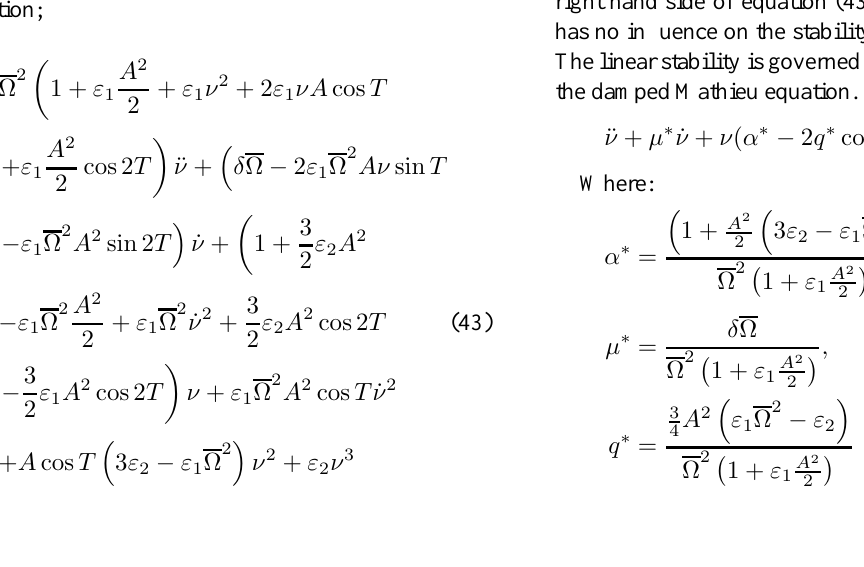
Fig. 4. Steady state frequency response and the instability boundary of the first mode, for the concentrated load case, i.e. ε 1 = 1 . 0449 , ε 2 = 0 . 9329 , ε 3 c = 0 . 17974 , δ = 0 . 02 and P = 0 . 2 , —— SHB-C, - - - - Instability Boundary. introducing a small perturbation ν ( T ) , i.e. by substi- tuting u ( T ) = A cos( T )+ ν ( T ) , into the equation (26), followed by use of the steady state conditions (28) and (29). This leads to the following non-linear variational